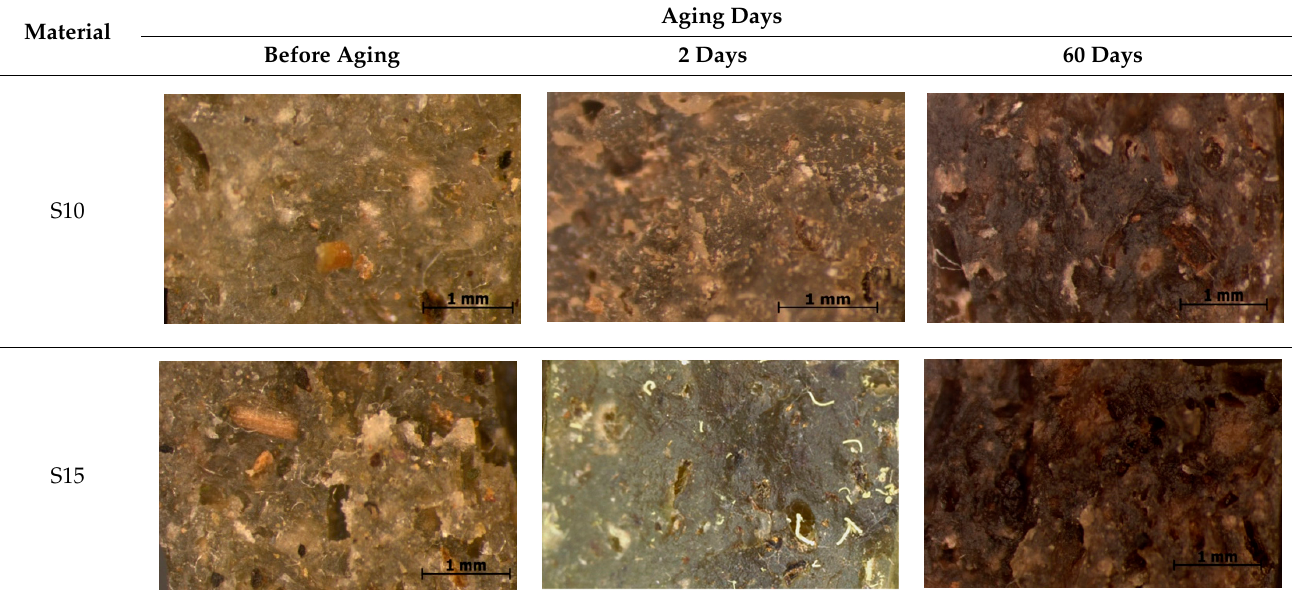
Graphical presentation of the calculated stress at break and elongation at break values are presented in Figures 16 and 17, respectively.